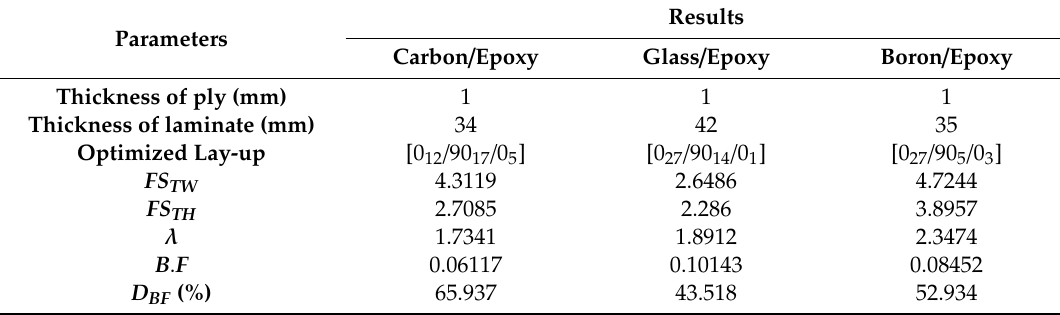
Table 5. Optimal lay-ups for [0 S / 90 T / 0 U ].